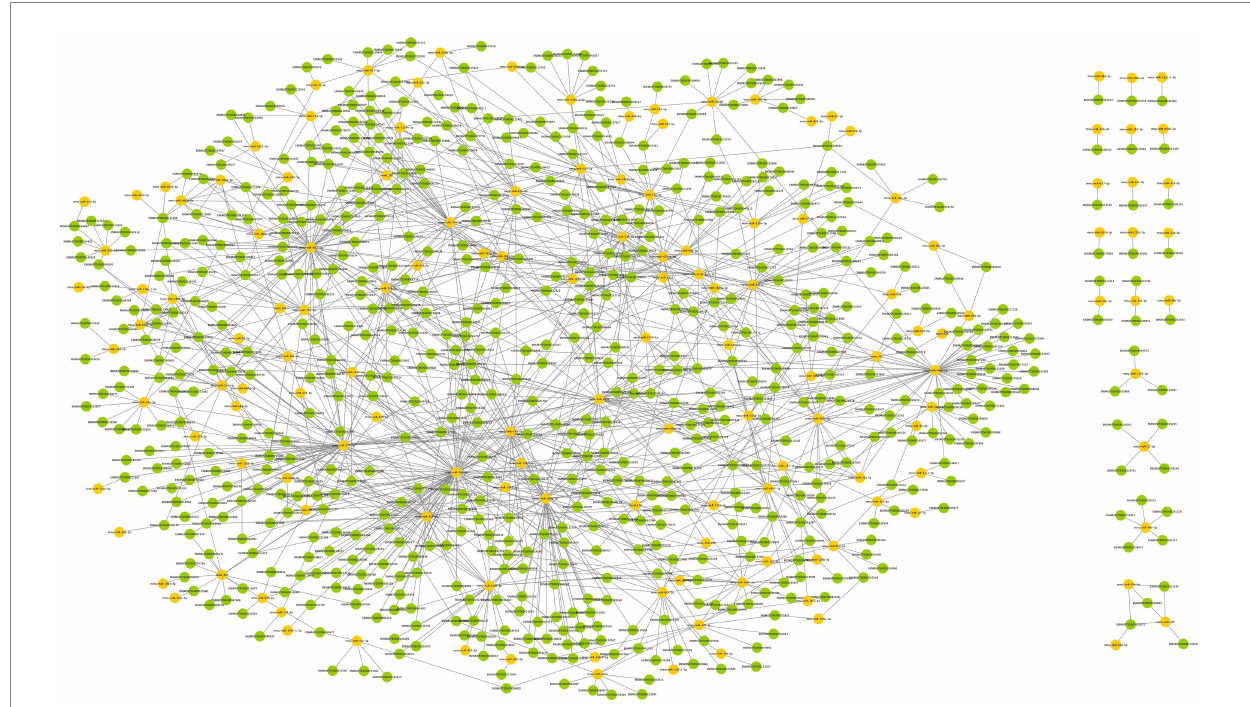
FIGURE 5 The DEmiRNA–DEmRNA regulatory network in postoperative period. Circles in yellow represent DEmiRNAs, and circles in green represent DEmRNAs. 144 DEmiRNAs were obtained to target 670 DEmRNAs with 1,195 pairs of